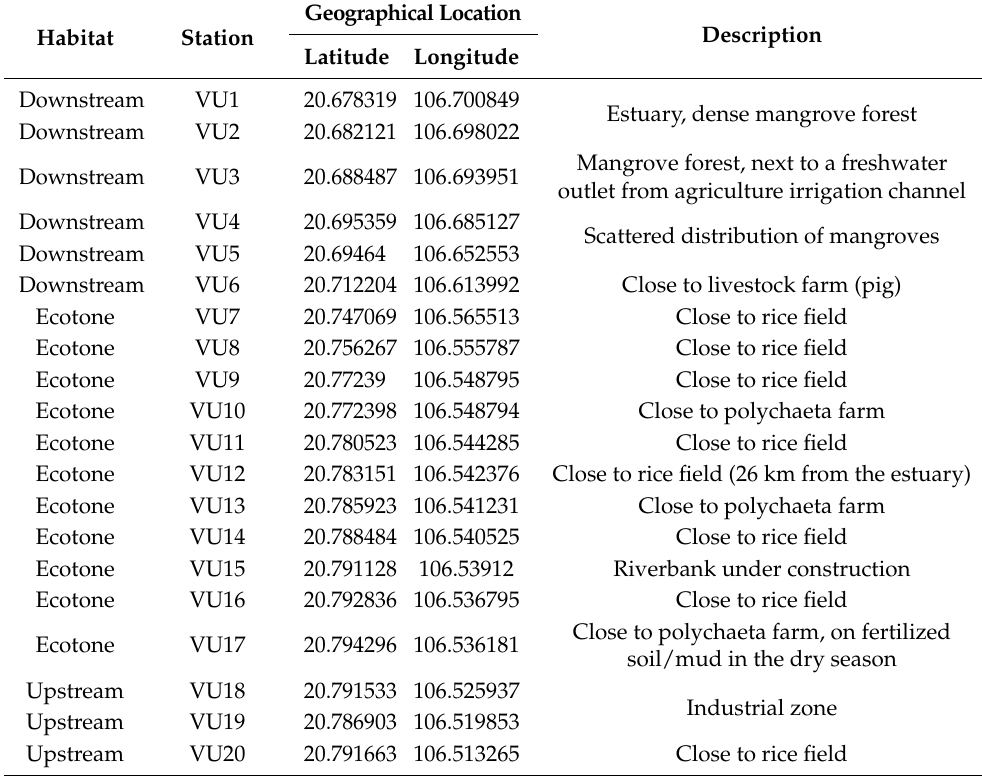
Table 1. Description of sampling sites.